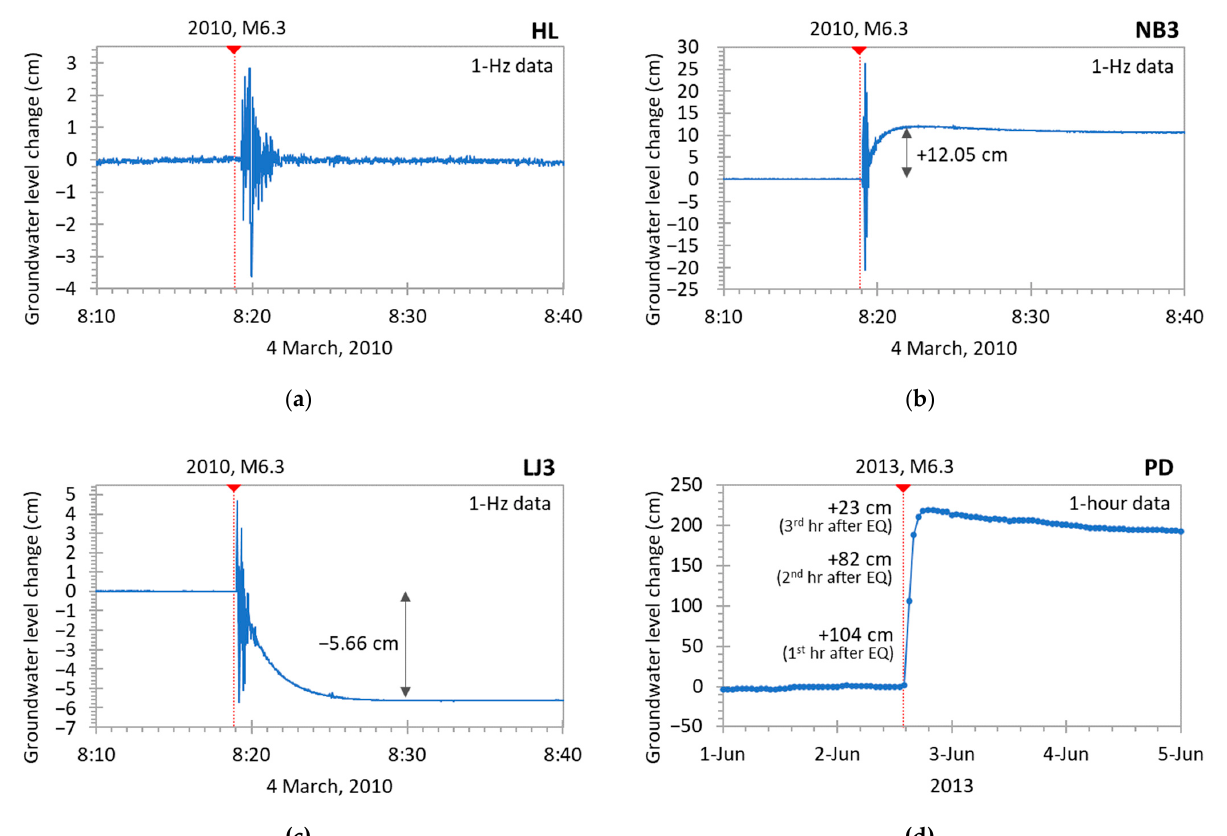
Figure 3. The process of coseismic changes in well water levels: ( a ) Oscillatory coseismic changes at the HL well, 1 Hz data, triggered by the 2010 M6.3 earthquake; ( b ) sustained coseismic rise at the NB3 well, 1 Hz data, triggered by the 2010 M6.3 earthquake; ( c ) sustained coseismic fall at the LJ3 well, 1 Hz data, triggered by the 2010 M6.3 earthquake; ( d ) delayed sustained coseismic rise at the PD well triggered by the 2013 M6.3 earthquake.